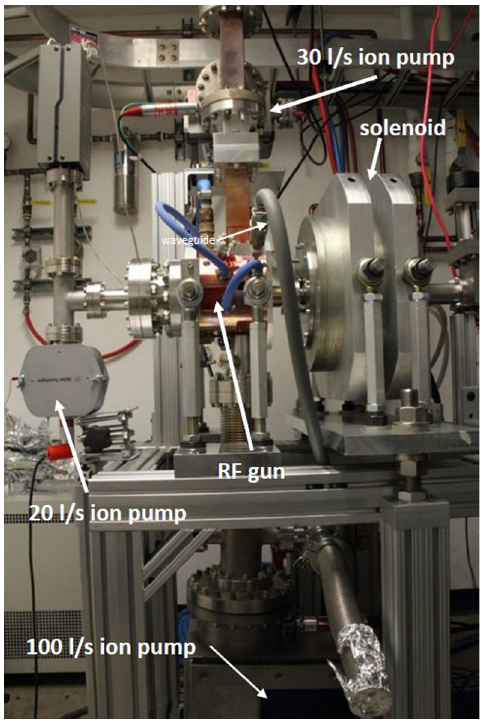
FIG. 12. Pictures of the rf gun installed in the Pegasus Laboratory at